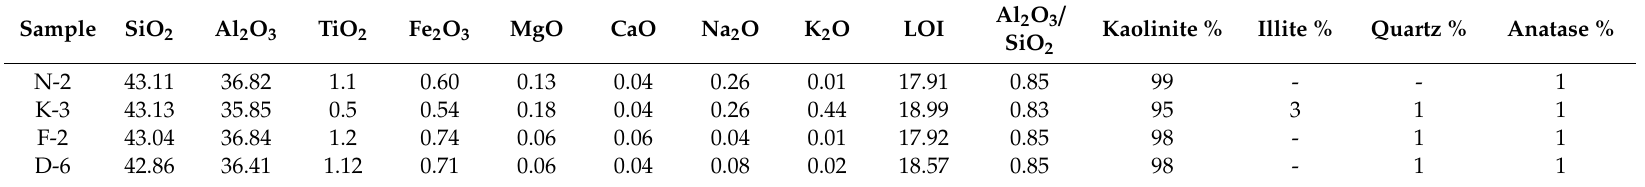
Table 1. Chemical and mineralogical compositions of the purified kaolin powder samples.